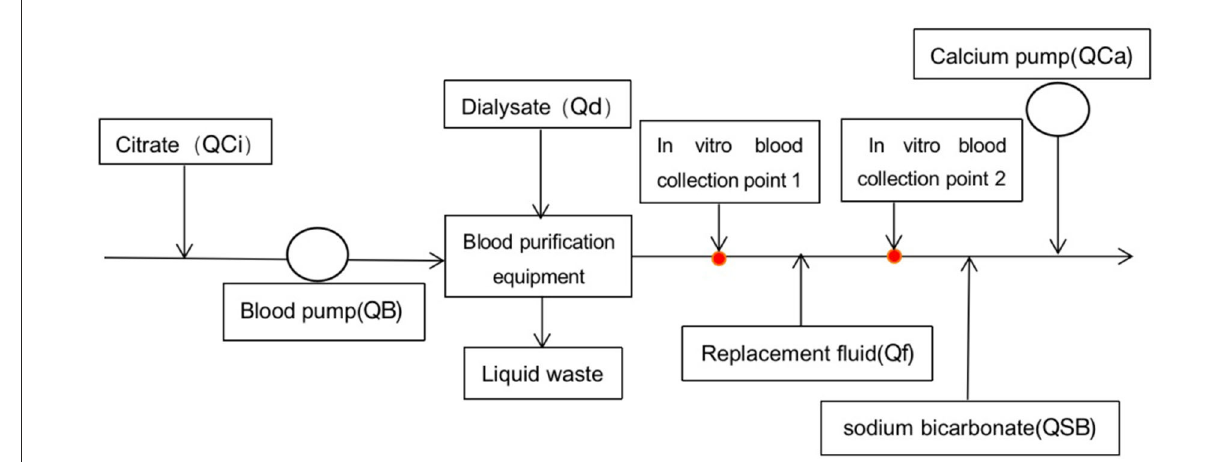
FIGURE1 Schematic diagram of hemodiafiltration. Point 1 was the site where the blood sample was collected for the protocol using calcium-free replacement fluid, and point 2 for the calcium-containing protocol.